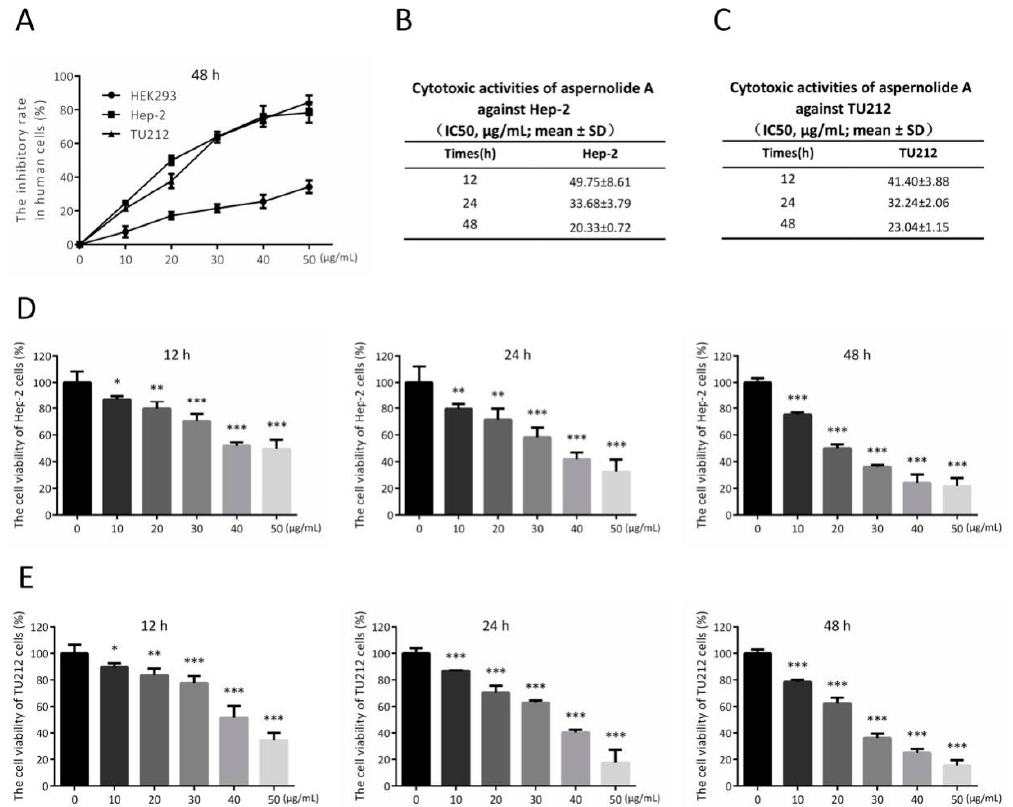
Figure 2. Aspernolide A provoked the apoptosis of human laryngeal carcinoma cells. ( A ) Cell viability and cytotoxicity was determined using the MTT assay. ( B , C ) IC50 values of Hep-2 and TU212 cells in 12, 24 and 48 h were shown. ( D , E ) Hep-2 and TU212 cells were treated with indicated concentrations of aspernolide A. After 12, 24 and 48 h, cell apoptosis was examined by MTT. (* p < 0.05, ** p < 0.01 or *** p < 0.001).